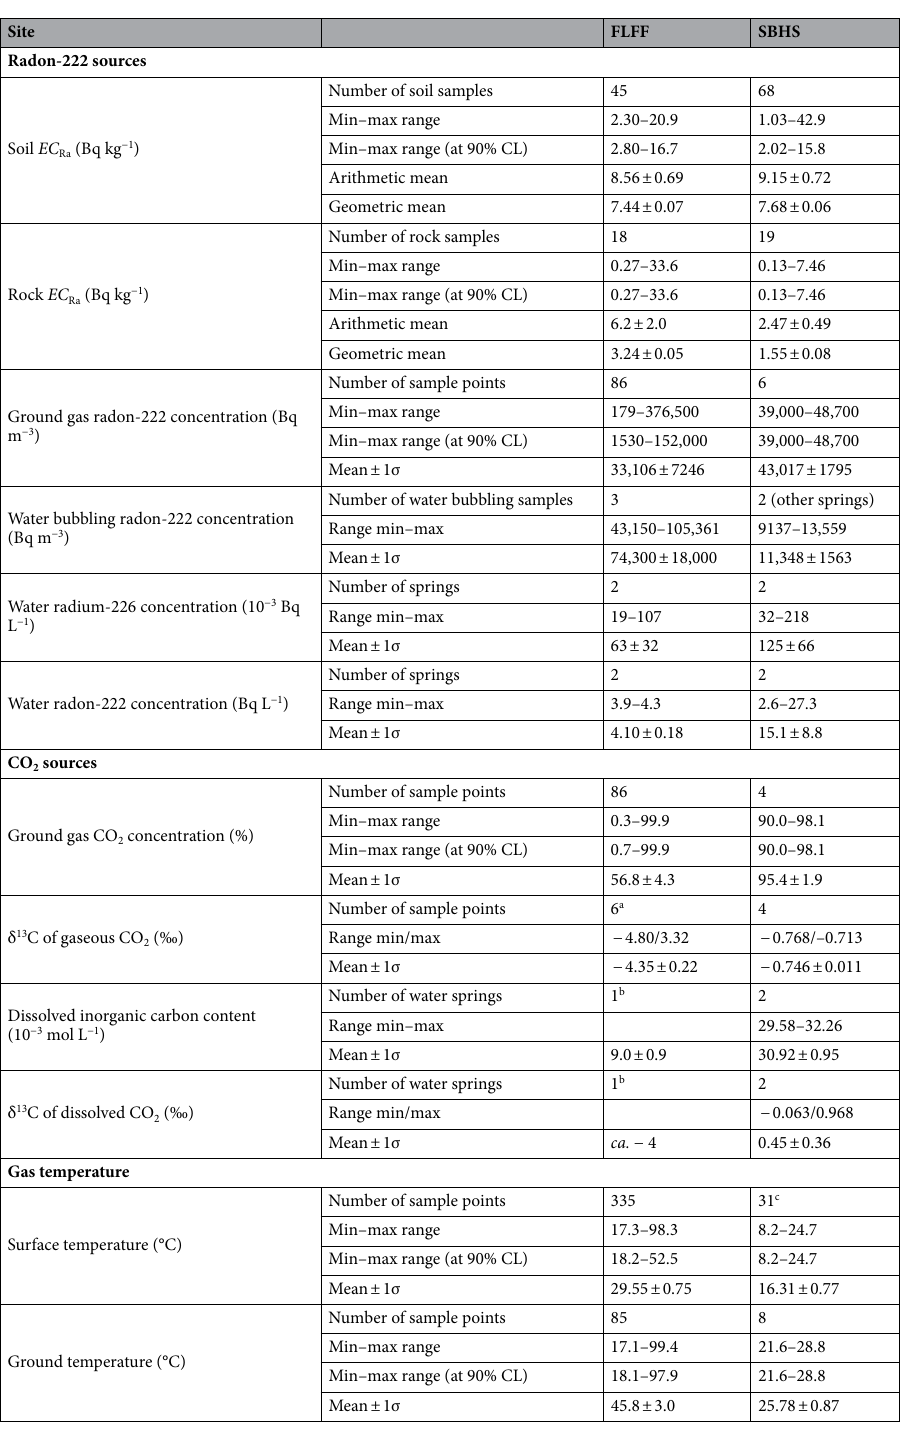
Table 2. Overview of radon and CO 2 sources data-set separately at FFLF and SBHS. Surface and ground gas temperature is also given for both sites. a Include four original data, one value from Ref. 7 and one value from Ref. 22 . b Data from Ref. 24 . c Inferred from surface temperature data used to estimate surface heat fluxes from Ref. 54